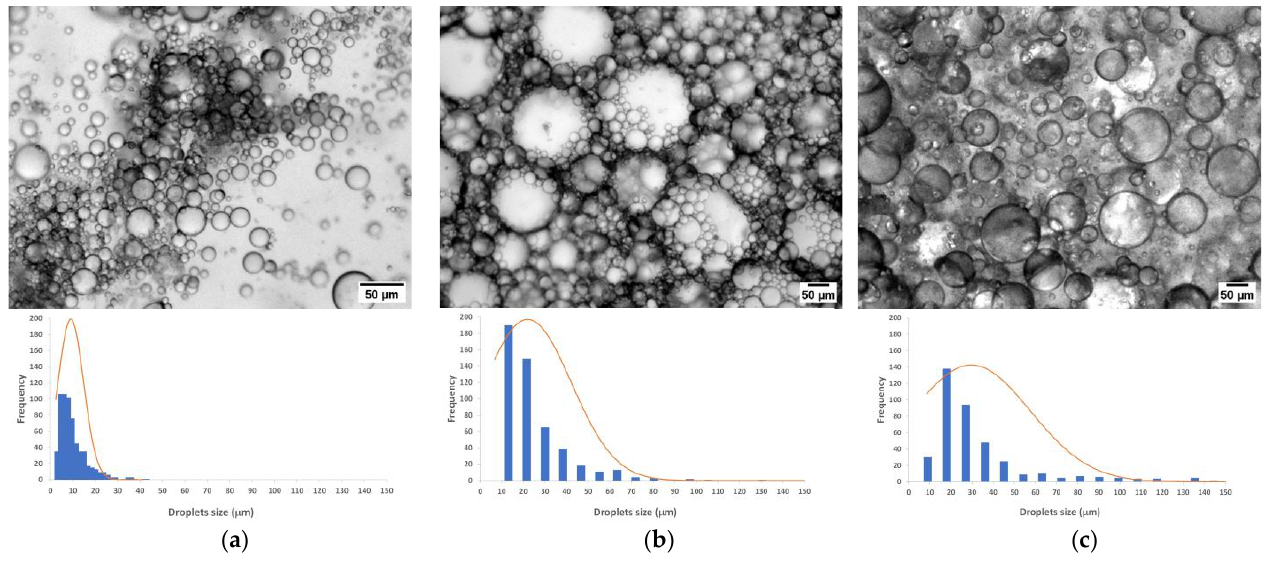
Figure 2. Optical contrast micrographs (5×), blue histogram and normal distribution (red curve) of droplets size ( μ m) by applying ultraturrax to the BSY extracts in water and vegetable oil (4:6), after 1 month: ( a ) pp 4M (50% emulsifying capacity); ( b ) pp 200 °C (67% emulsifying capacity); ( c ) xanthan gum (86% emulsifying capacity).